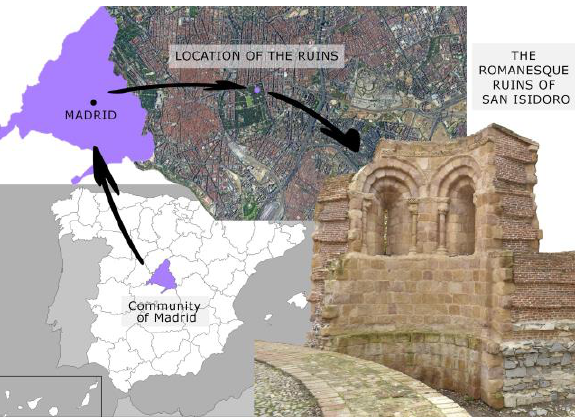
Figure 3. Current location of the ruins, in the north-east of the Retiro park at the centre of